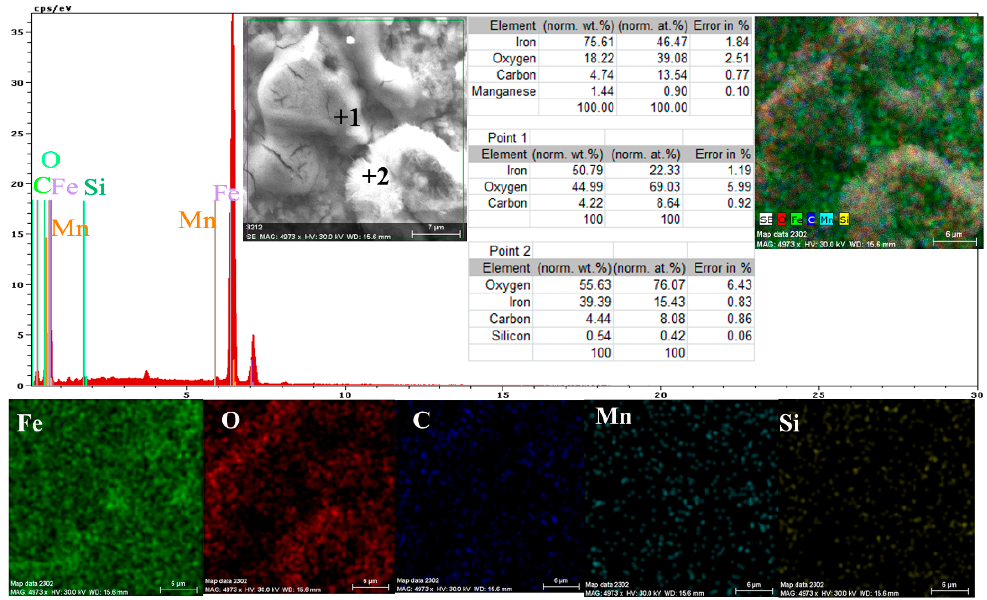
Figure 4. EDS spectrum, compositions and distribution of elements over a portion of the sample surface (Figure 3c)).